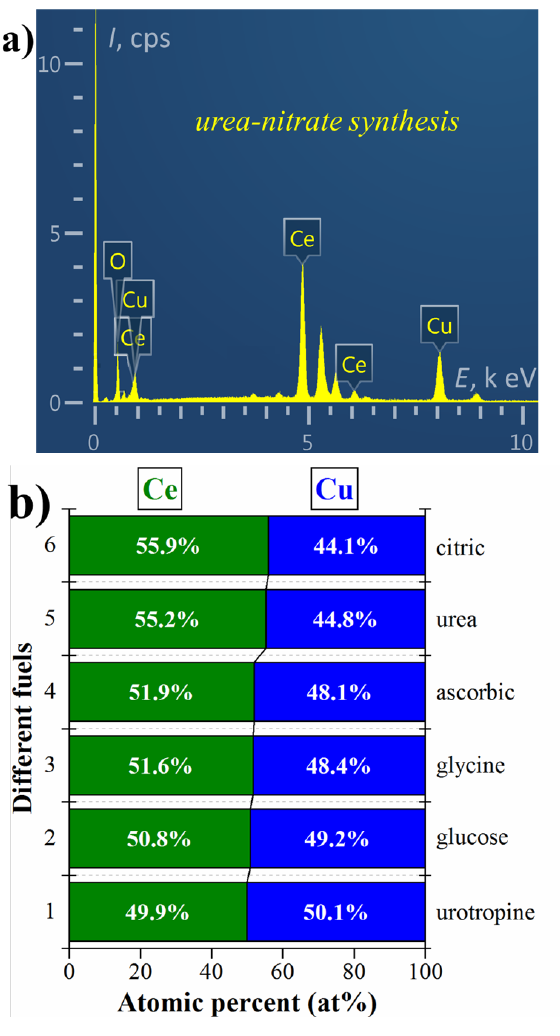
Figure 1: EDX spectra of CuO/CeO 2 -urea sample (a); the ratio of Ce:Cu in the products obtained of CuO/CeO 2 -urotropine, CuO/CeO 2 - glucose, CuO/CeO 2 -glycine, CuO/CeO 2 -ascorbic, CuO/CeO 2 -urea, CuO/CeO 2 -citric, respectively, synthesized by the SCS method (b).